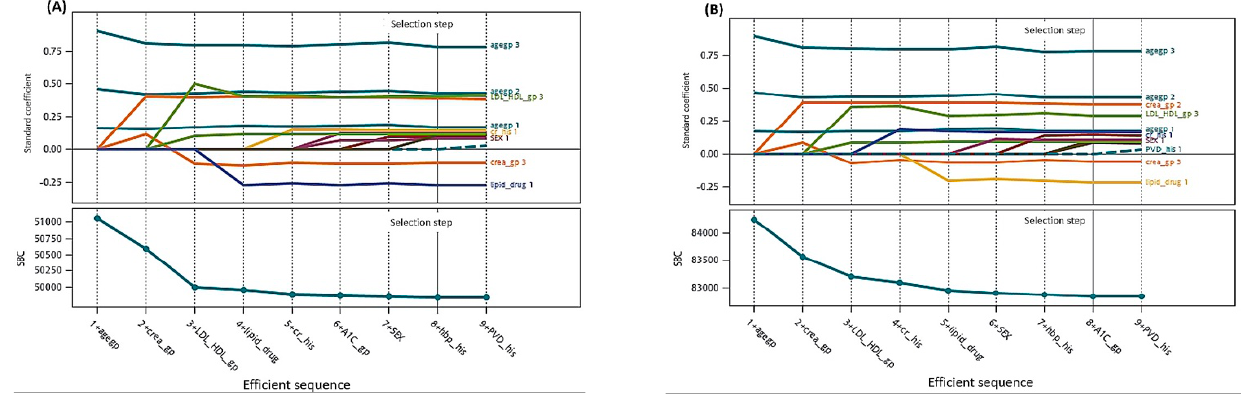
Figure 1. The coefficient progression for time with selection steps for model selection using LASSO method: ( A ) 7-year and ( B ) 10-year model.